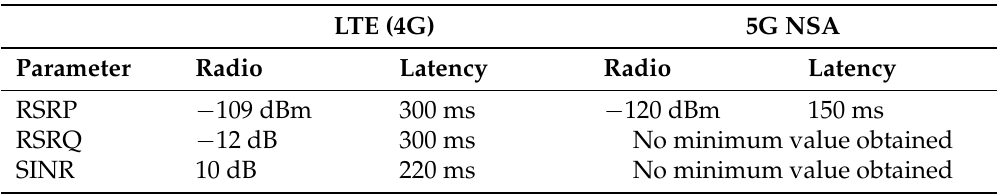
Table 3. Radio KPIs. 4G/5G radio threshold values to guarantee availability 99% of the time for a latency lower than 500 ms.